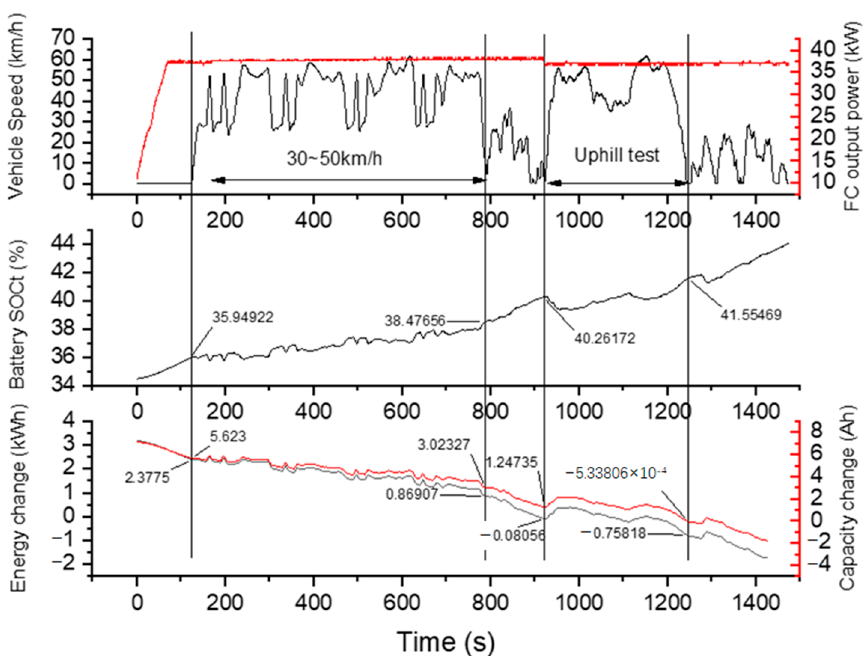
Figure 7. Overtaking test and uphill test.